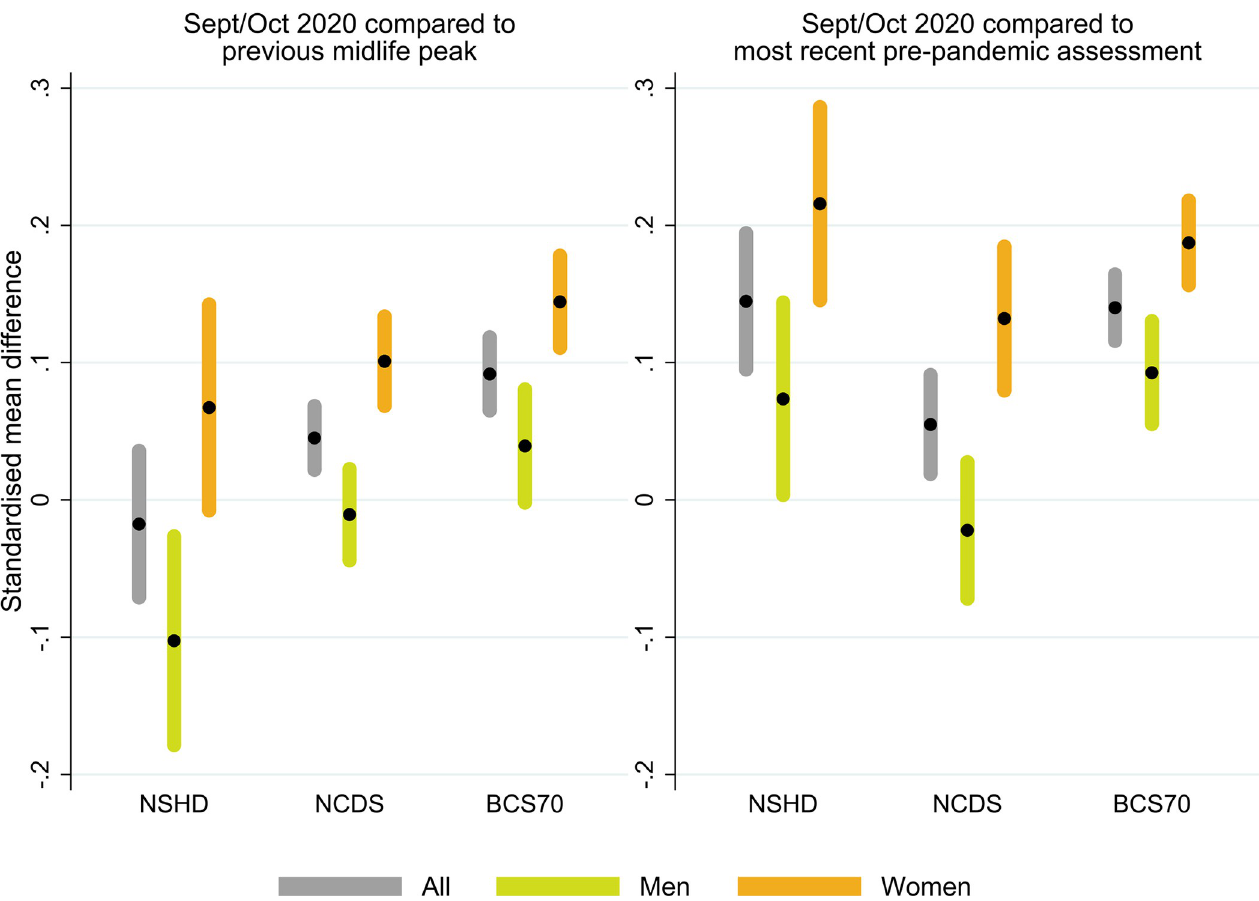
Fig 4. Standardised mean difference in cross-cohort factor scores between September/October 2020 and pre-pandemic peak in midlife and most recent pre-pandemic assessment. Unadjusted results. 95% confidence intervals are indicated in shaded areas. BCS70: 1970 British Cohort Study; NCDS: 1958 National Child and Development Study; NSHD: 1946 National Survey of Health and Development. Previous midlife peaks correspond to years 1999 (NSHD), 2000 (NCDS), and 2012 (BCS70). Most recent pre-pandemic assessments correspond to 2015 (NSHD), January/March 2020 (NCDS), and 2016 (BCS70).